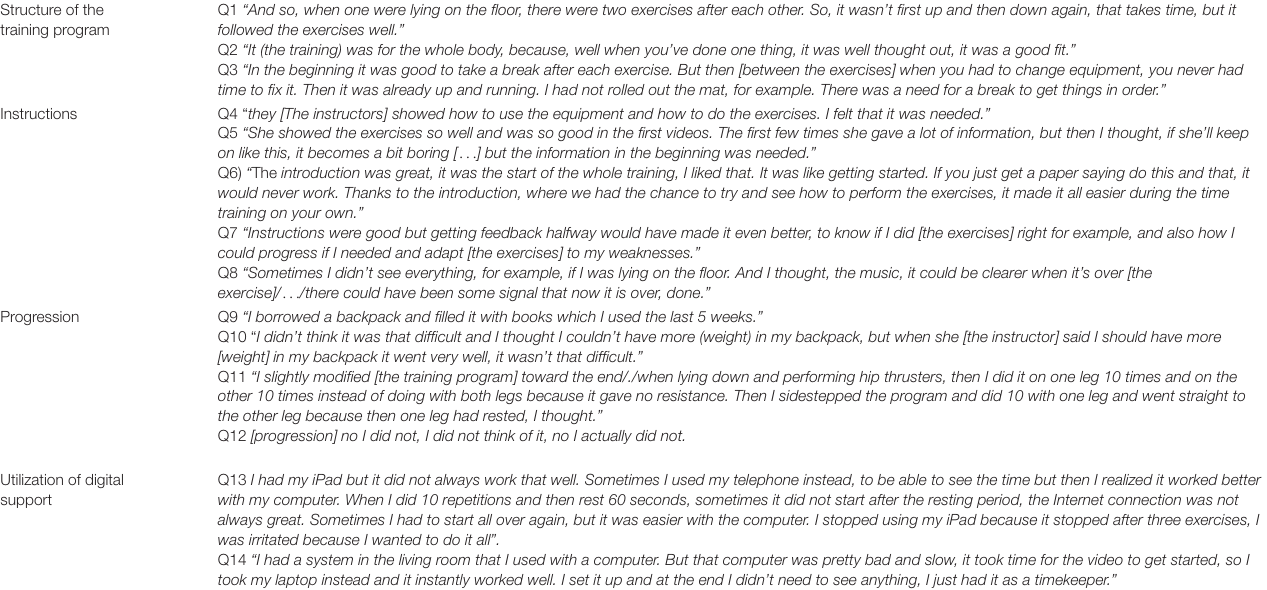
TABLE 4 | Quotations from the interviewed participants categorized according to subcategories. Q = quote. Structure of the training